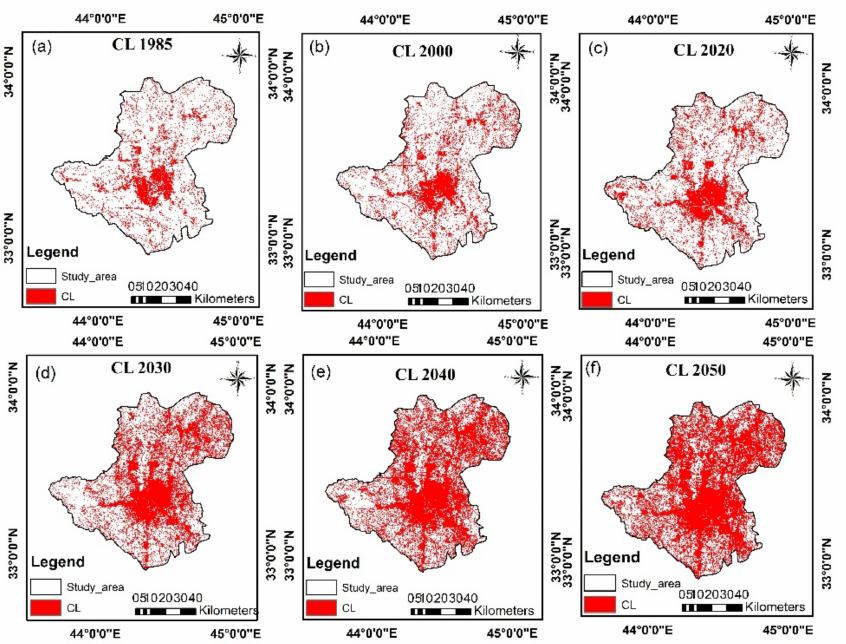
Figure 13. Visualization of chronological Urban CL sprawl from 1985 to 2050. ( a ) Urban CL 1985, ( b ) Urban CL 2000, ( c ) Urban CL 2020, ( d ) Urban CL 2030, ( e ) Urban CL 2040, and ( f ) Urban CL 2050. (Note: urban CL sprawl represents in red color in subgraphs).